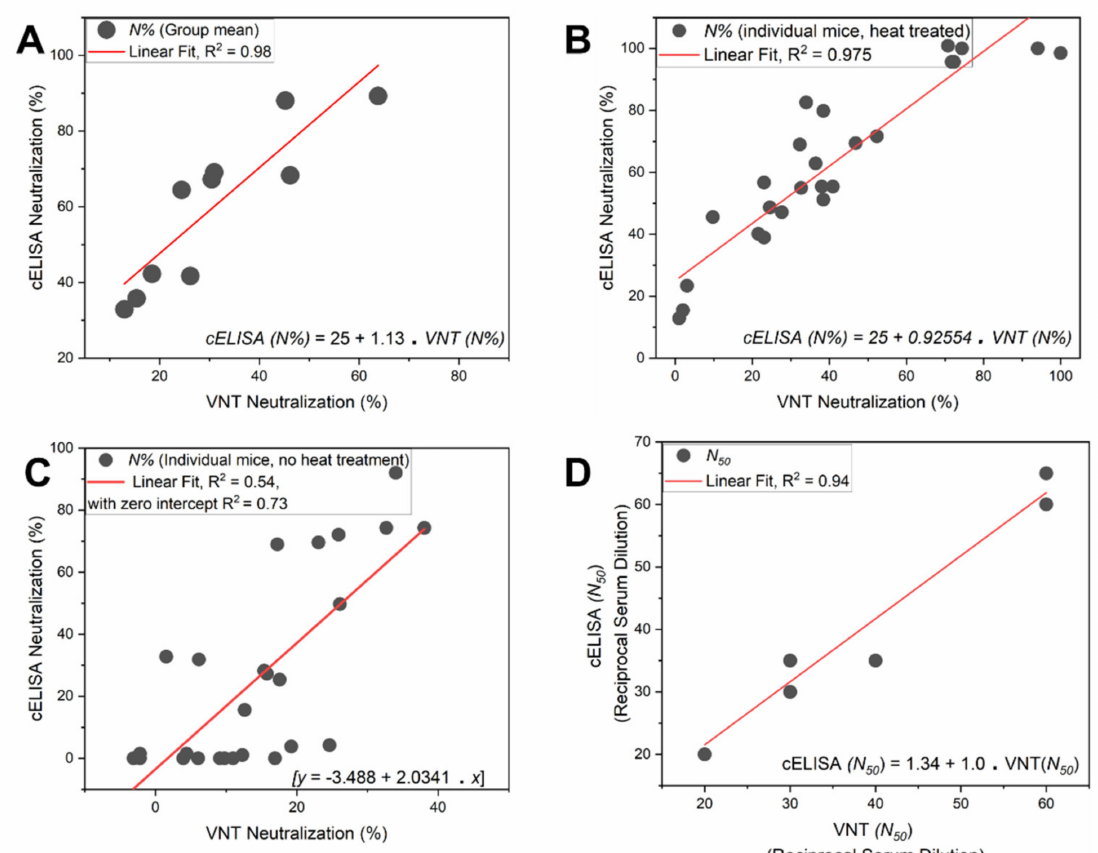
Figure 4. The correlated data belong to six groups of mice, comprising 24 different weakly-to-moderately neutralizing murine sera at different dilutions: ( A ) the correlation between combined group mean neutralization (%) values from the VNT assay and heat-inactivated sera cELISA assay was R 2 = 0.98, n = 10; ( B ) the correlation between individual mouse immune serum neutralization (%) values from the VNT assay and heat treated serum cELISA assay was R 2 = 0.975, n = 25; ( C ) the correlation between individual mouse immune serum neutralization (%) values from the VNT assay and untreated serum cELISA assay was R 2 = 0.54, n = 25; ( D ) the correlation between reciprocal serum dilutions that corresponded to 50% neutralization efficacy ( N 50 ) between both assays (VNT and heat-treated serum cELISA) using heat-inactivated weak-to-moderately neutralizing murine sera profiles that were within the detectable range of both